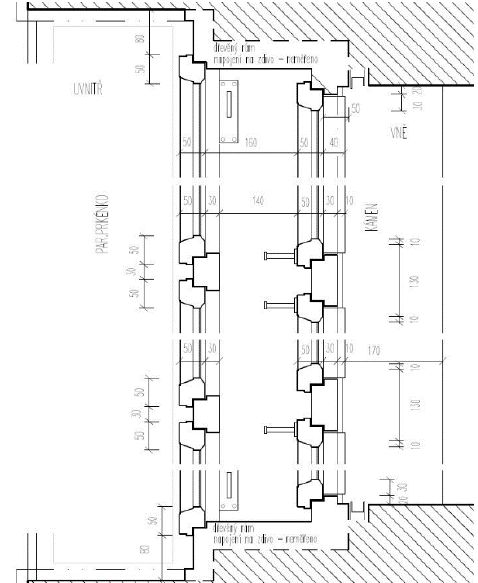
Figure 9. Section through window in MISYS SPRÁVA